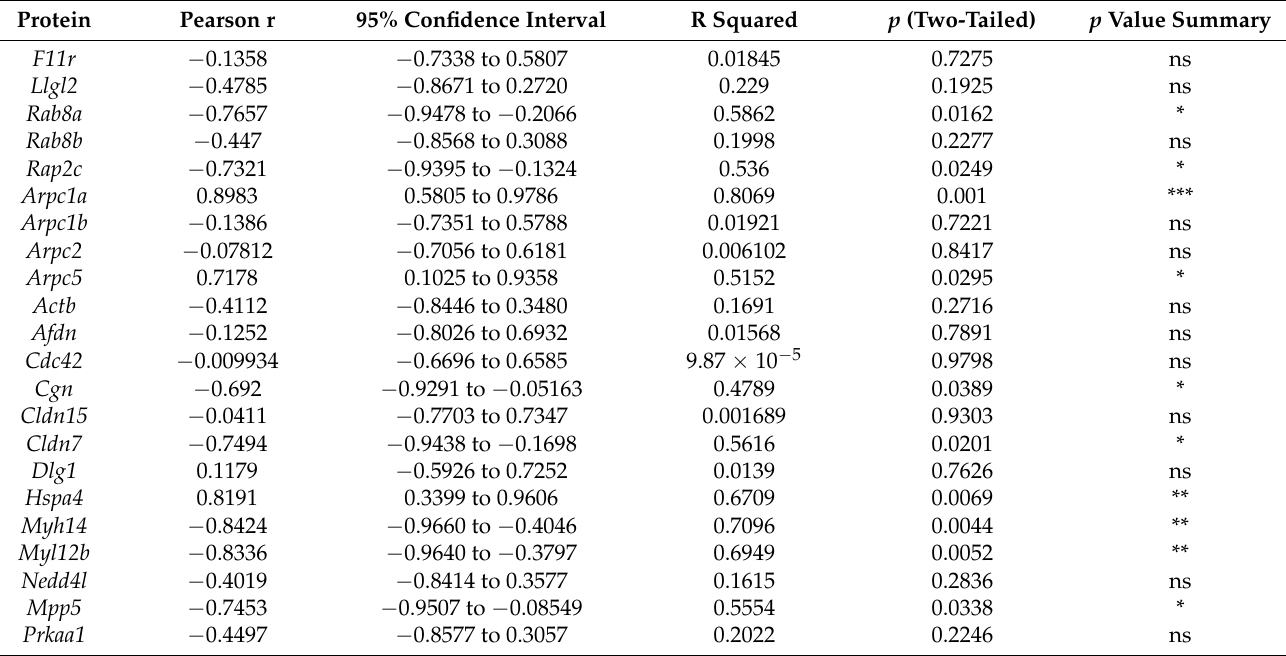
Table 1. Correlations of TJ-related proteins and intestinal Table 1 . Correlations of TJ-related proteins and intestinal permeability .